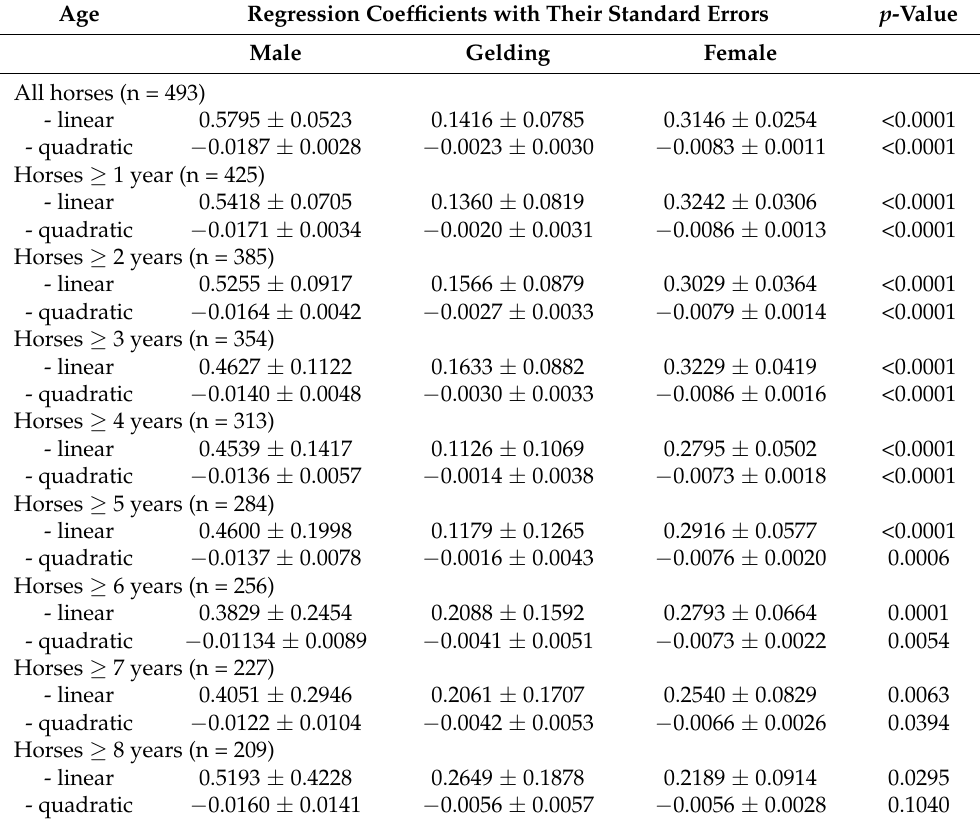
Table 5. Estimates of linear and quadratic regression coefficients for age by sex with their standard errors (SE) and p -values for CPL-scores in all Rhenish German draught horses and with an age greater equal than 1, 2, 3, 4, 5, 6, 7 and 8 years, using model 1 with a normal distribution function. Age Regression Coefficients with Their Standard Errors p